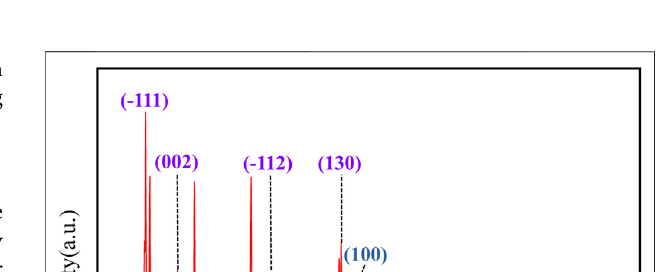
FIGURE 1 | Preparation process of RGO-CB/CIP composites.